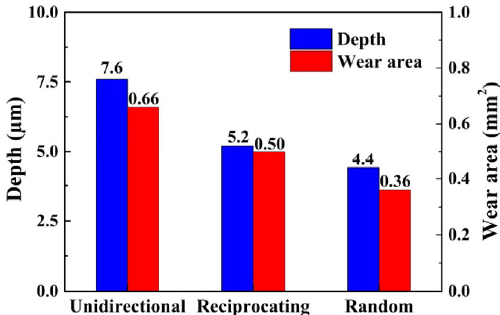
Fig. 16 Composite fretting trajectory curves under different impact forces.